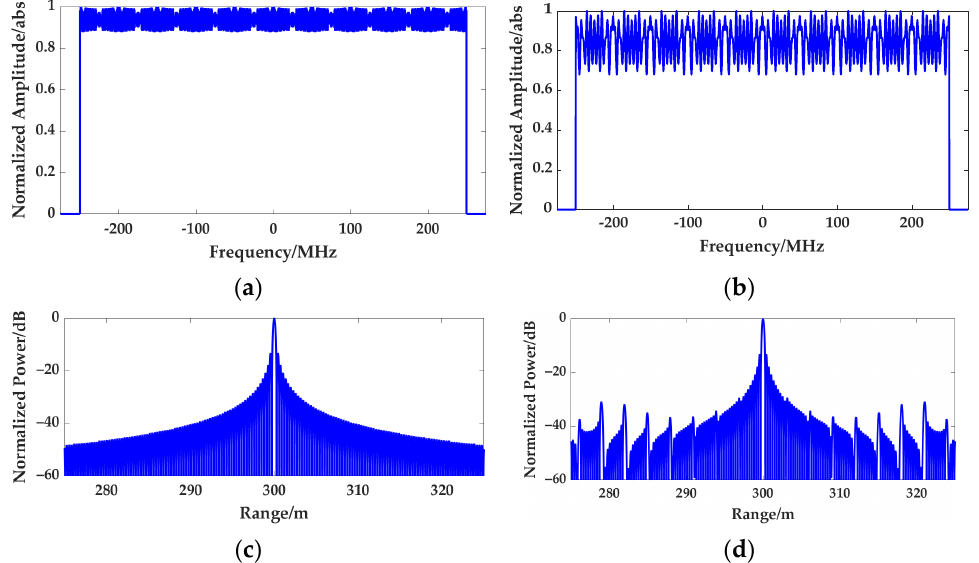
Figure 6. Synthesized results under large and small time-bandwidth product conditions: ( a , c ) synthesized wideband spectrum and HRRP based on the LFM subpulse with the time-bandwidth product of 500; ( b , d ) synthesized wideband spectrum and HRRP based on the LFM subpulse with the time-bandwidth product of 50.